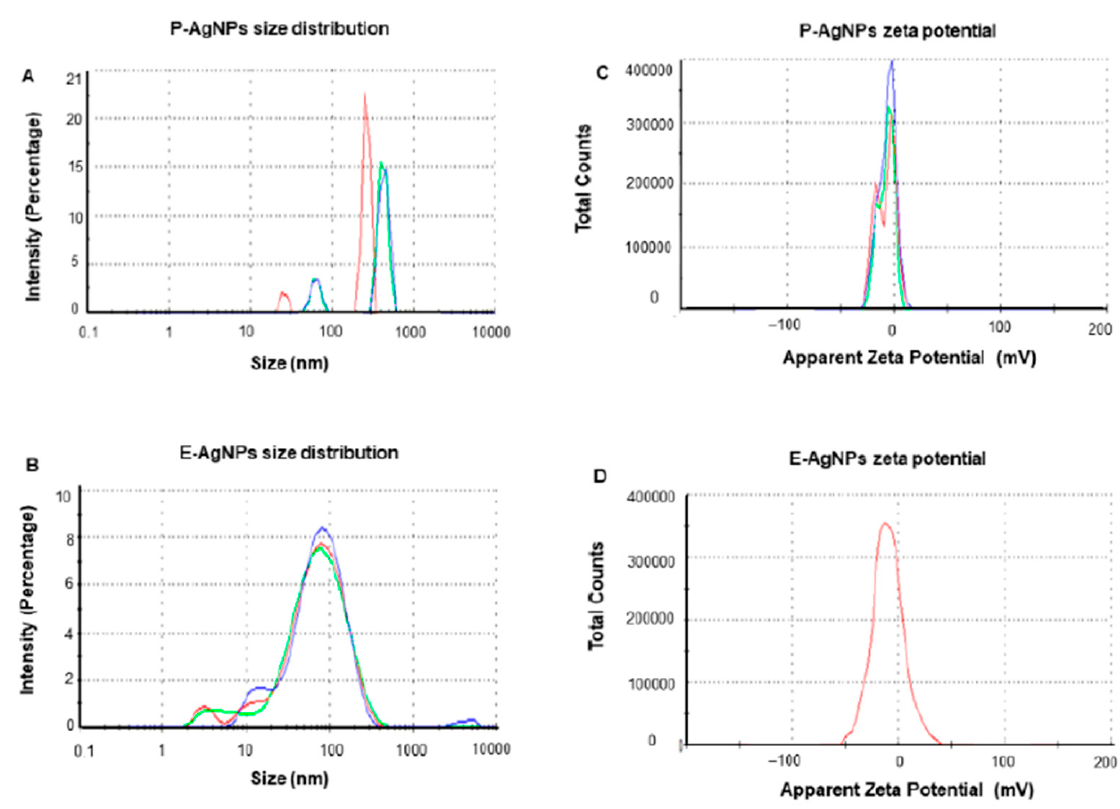
Figure 9. DLS analysis for P-AgNPs and E-AgNPs. ( A , B ): distributions for size and intensity. ( C , D ): zeta-potential for surface charge. Reprinted from an open-source article [134].